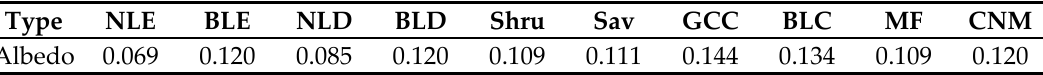
Figure 8. Global maps of the yearly snow-free VIS soil albedo ( a ) and the number of valid retrievals in 2005 ( b ). Table 5. The yearly mean values of the snow-free soil VIS albedo retrieved using the NSM model for different vegetation types in 2005.